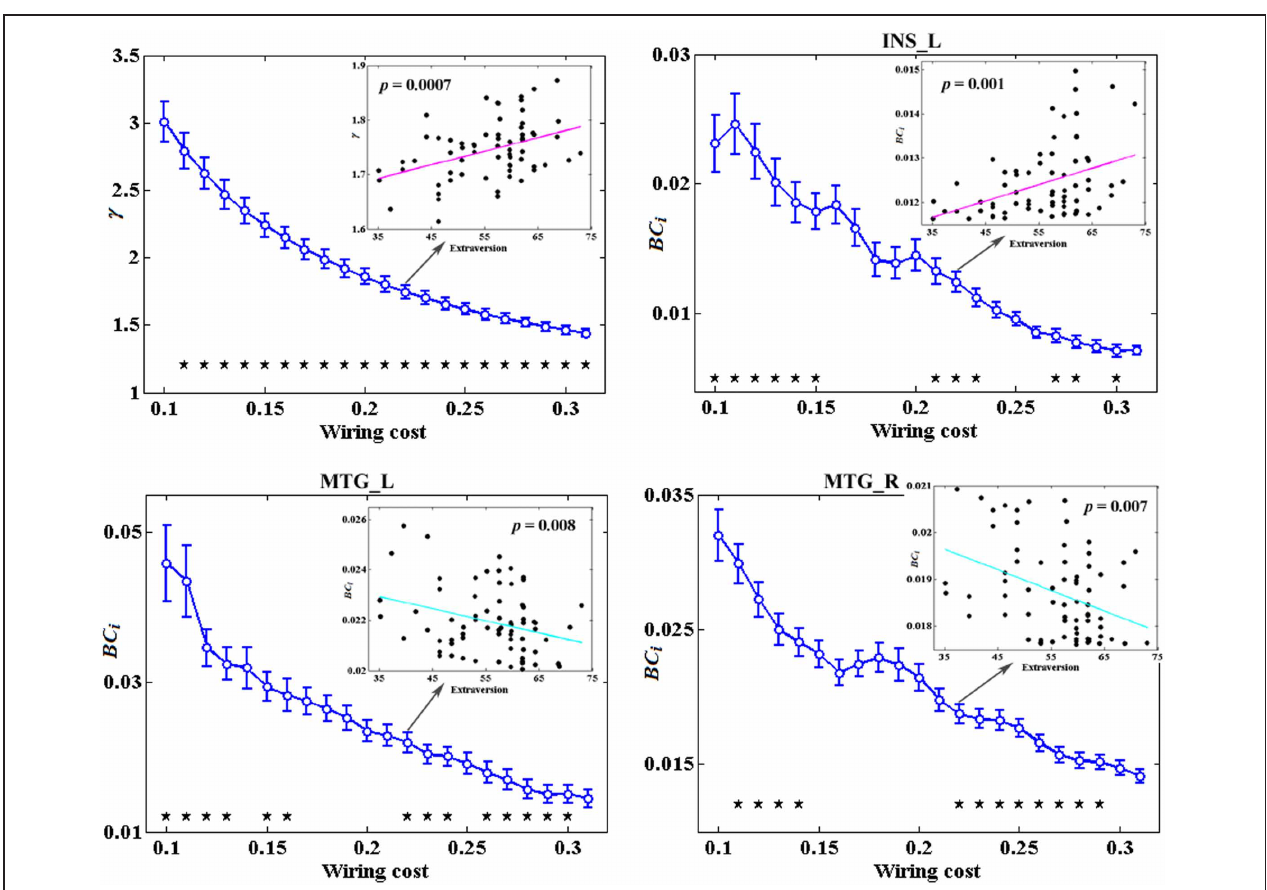
FIGURE 3 | The topological characteristics of network metrics which have significant associations with extraversion, as a function of wiring cost thresholds. The asterisk indicates the threshold where the significant